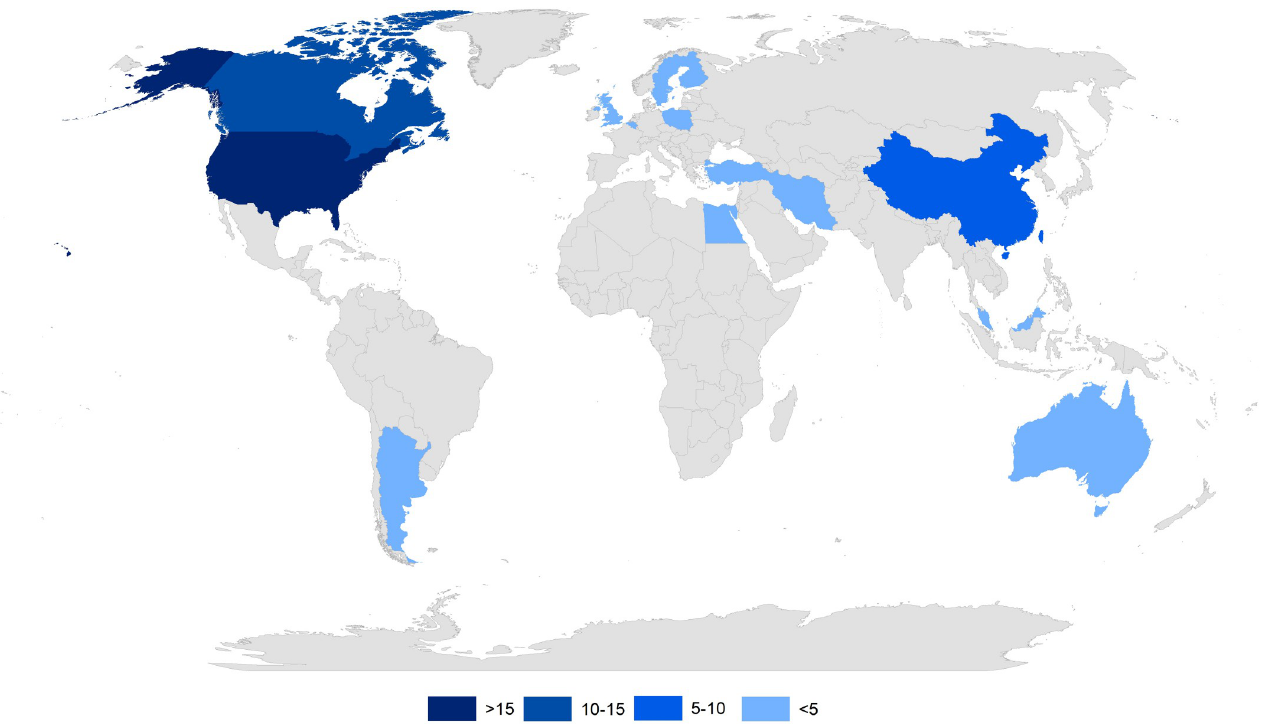
Fig 2. Countries to which the articles used in the record screening of articles relate.